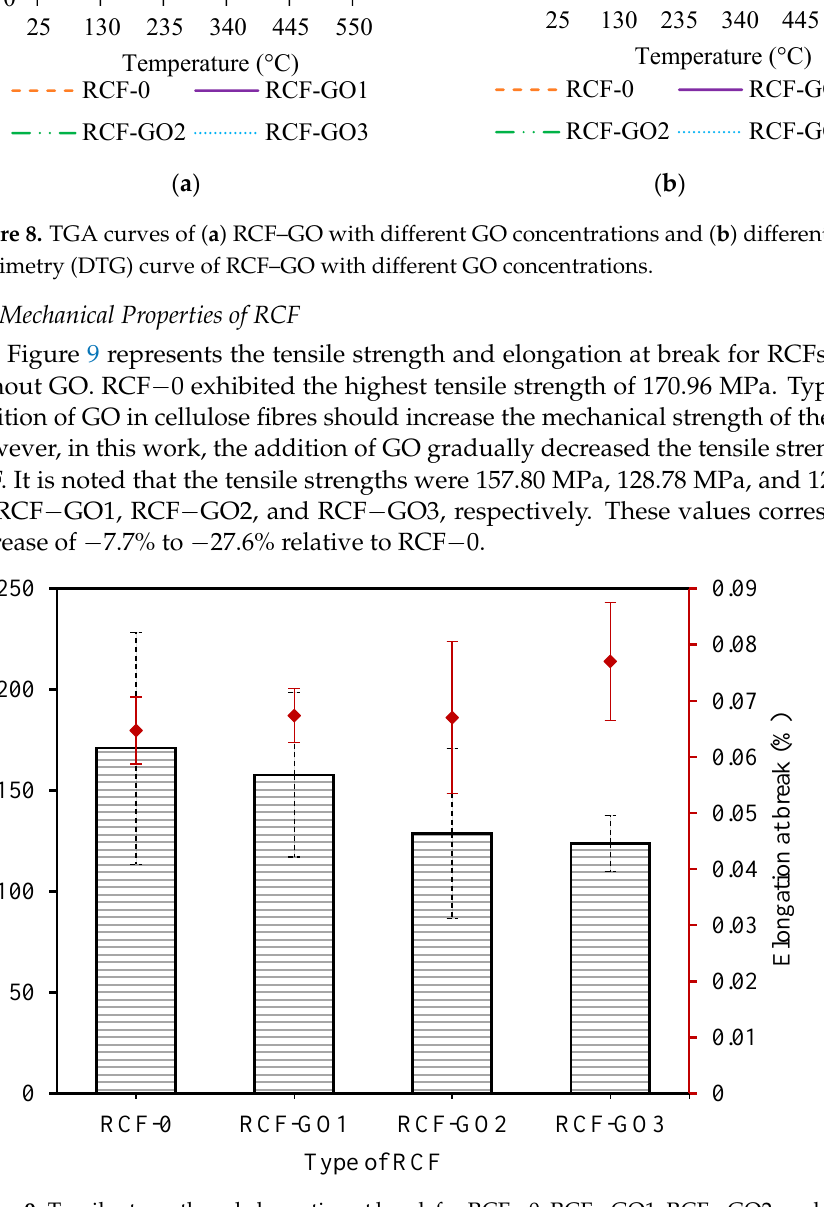
Figure 9. Tensile strength and elongation at break for RCF − 0, RCF − GO1, RCF − GO2, and RCF − GO3.